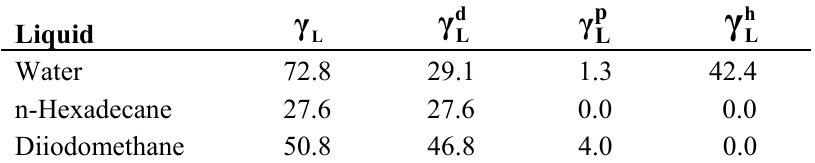
Table 2. Surface free energy components of water, n-hexadecane, and diiodomethane: surface free energy, dispersive component, polar component, and hydrogen-bonded component. Liquid Water 72.8 n-Hexadecane